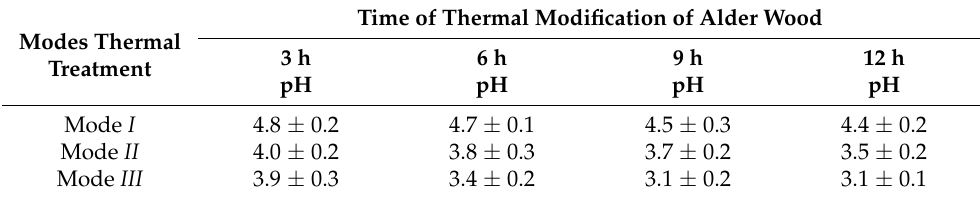
Table 5. Measured average pH values of alder wood in the process of thermal treatment. Modes Thermal